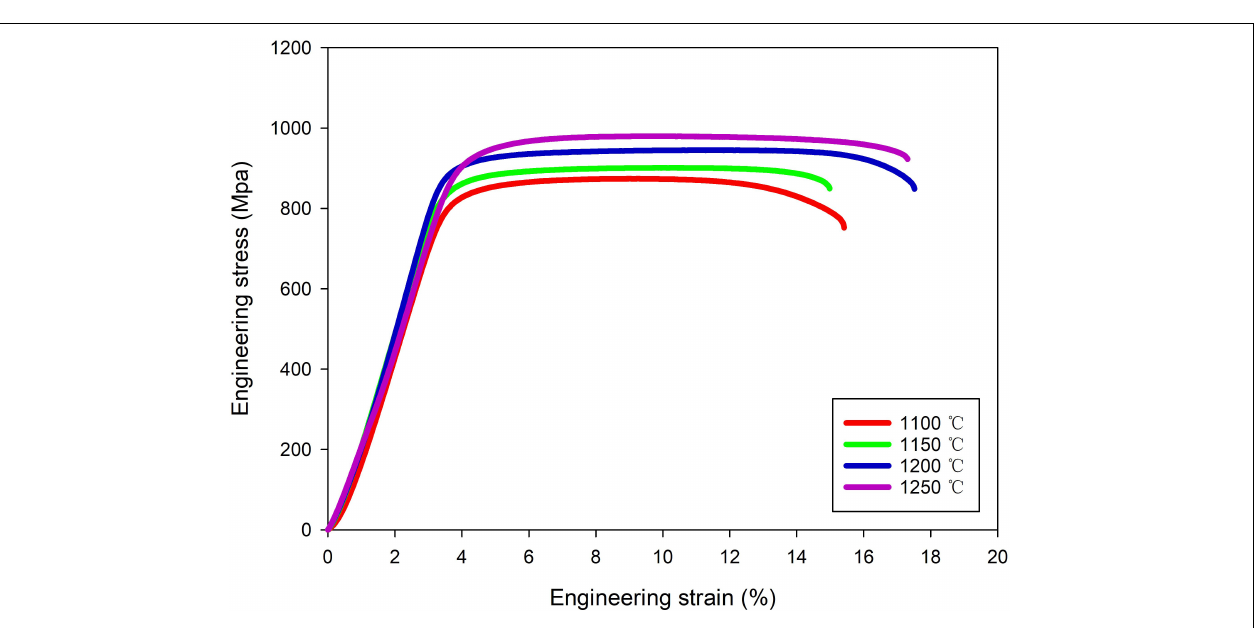
Frontiers in Materials |